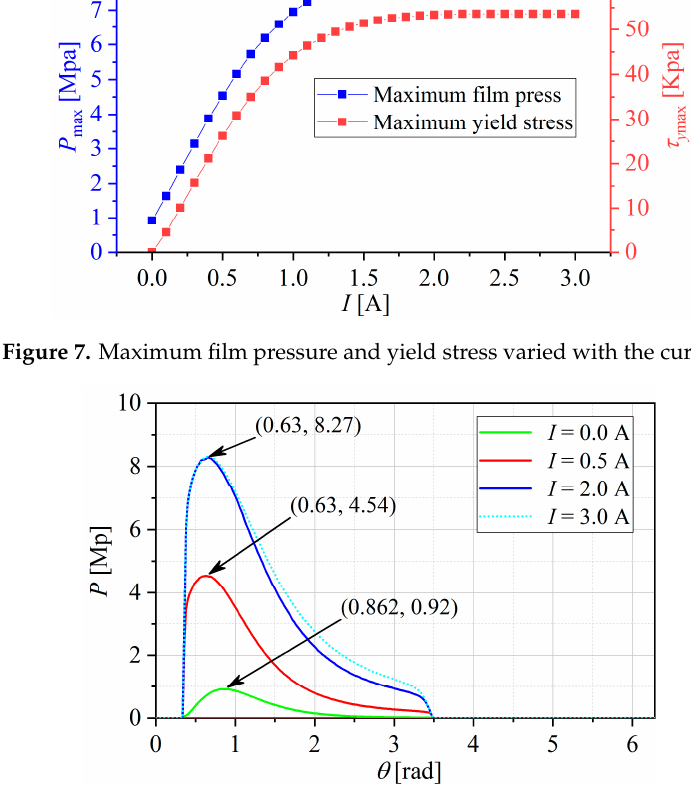
Figure 8. Pressure distribution in the middle plane of MRD under several currents.